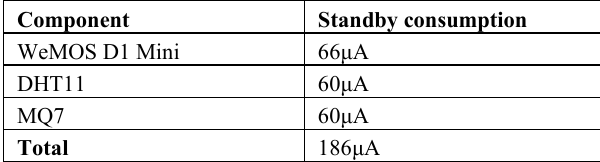
Figure.2. Connection diagram